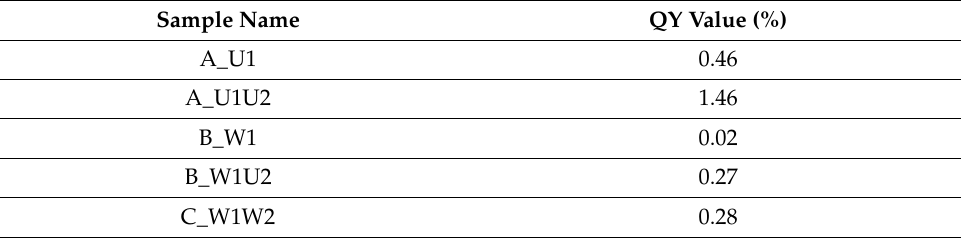
Table 2. Quantum yield values calculated for samples obtained via Routes A, B, and